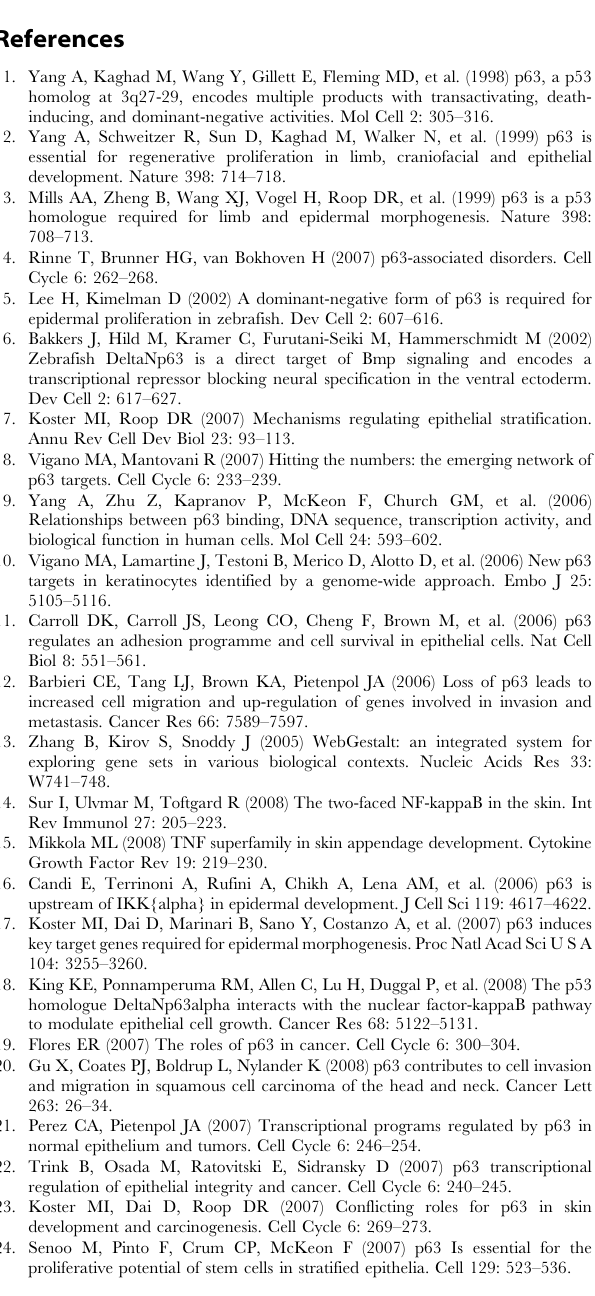
Table S4 List of primers used in ChIP and RT-PCR